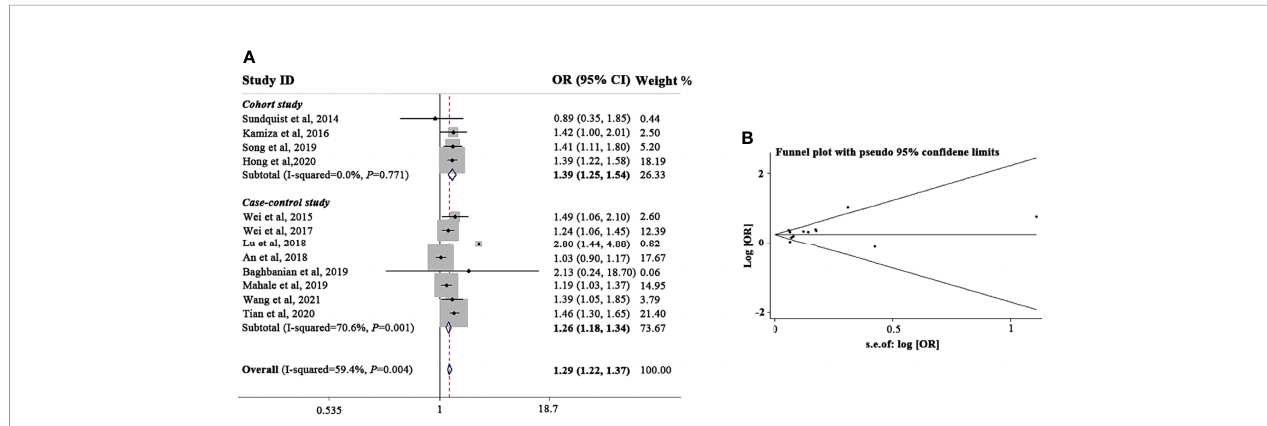
FIGURE 1 | Meta-analysis and summary OR of the association between HBV infection and gastric cancer. (A) Summary OR of the association between HBV infection and gastric cancer. (B) Funnel plot of the studies included in the meta-analysis of the association between HBV infection and gastric cancer. HBV, hepatitis B virus; OR, odds ratio; CI, con fi dence